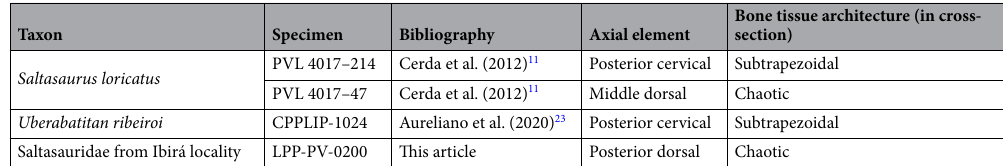
Table 1. Camellate architecture in the presacral centra of